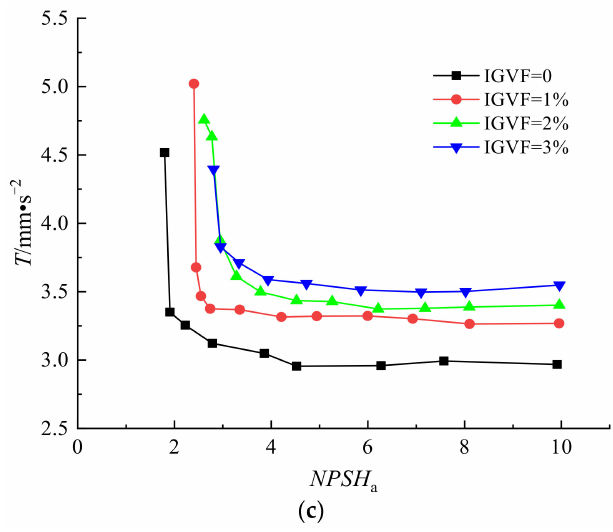
Figure 8. Vibration intensity of the model pump outlet under different IGVF conditions and different flow rates: ( a ) 0.75 Q ld ( b ) 1.0 Q ld and ( c ) 1.25 Q ld .